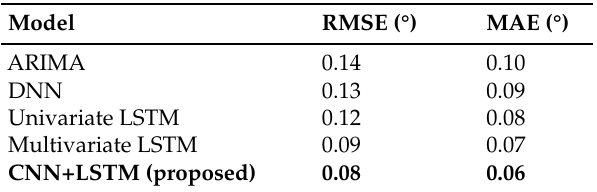
Table 3. RMSEs and MAEs of each model at “JingHai-VI” test set-2.